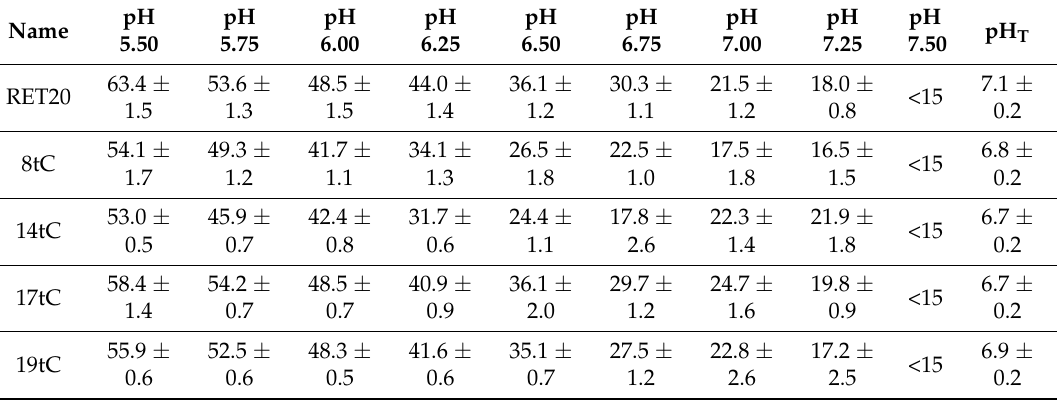
Table 2. The melting temperatures (T m ) evaluated from denaturing profiles obtained at different pH values. pH T determined from circular dichroism (CD)